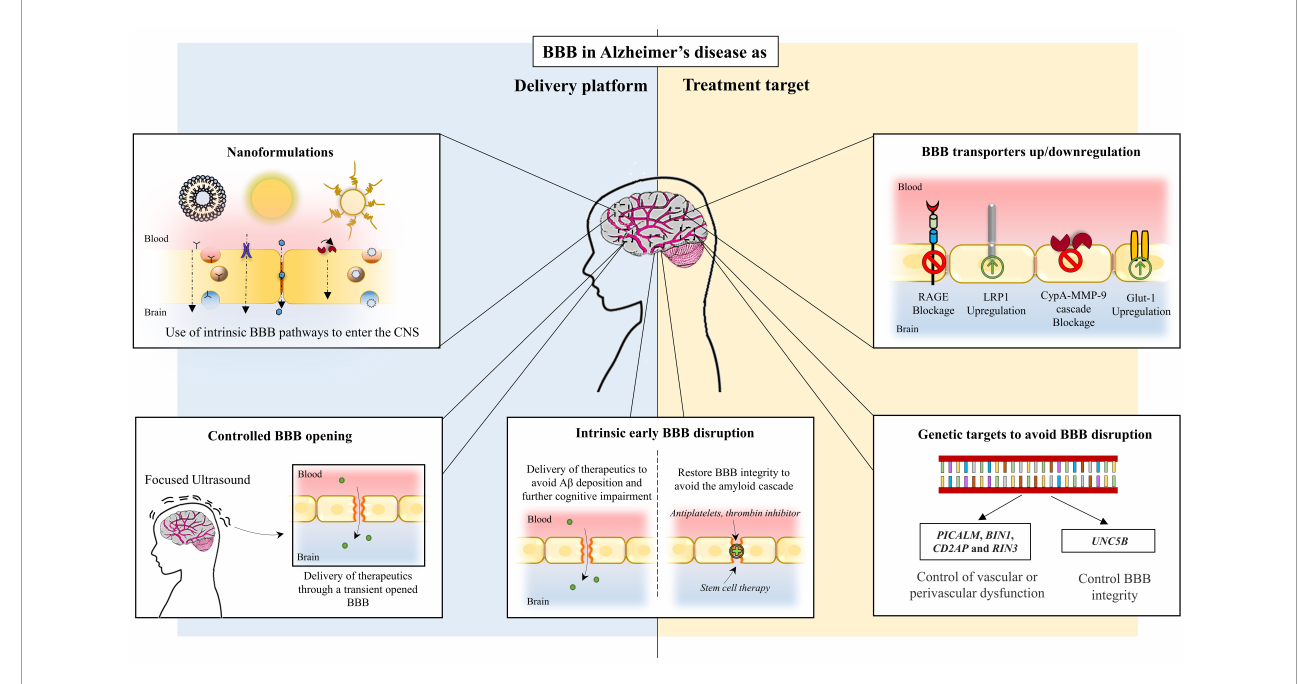
FIGURE2 Conceptual blood-brain barrier targets in Alzheimer’s